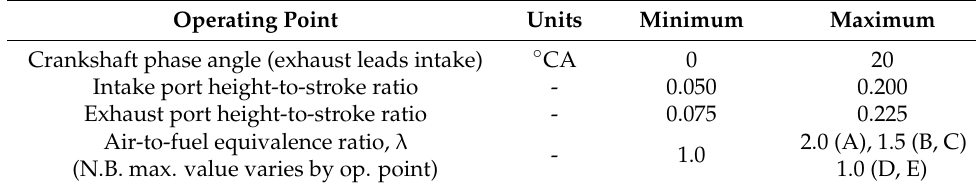
Table 5. Design of experiment parameter